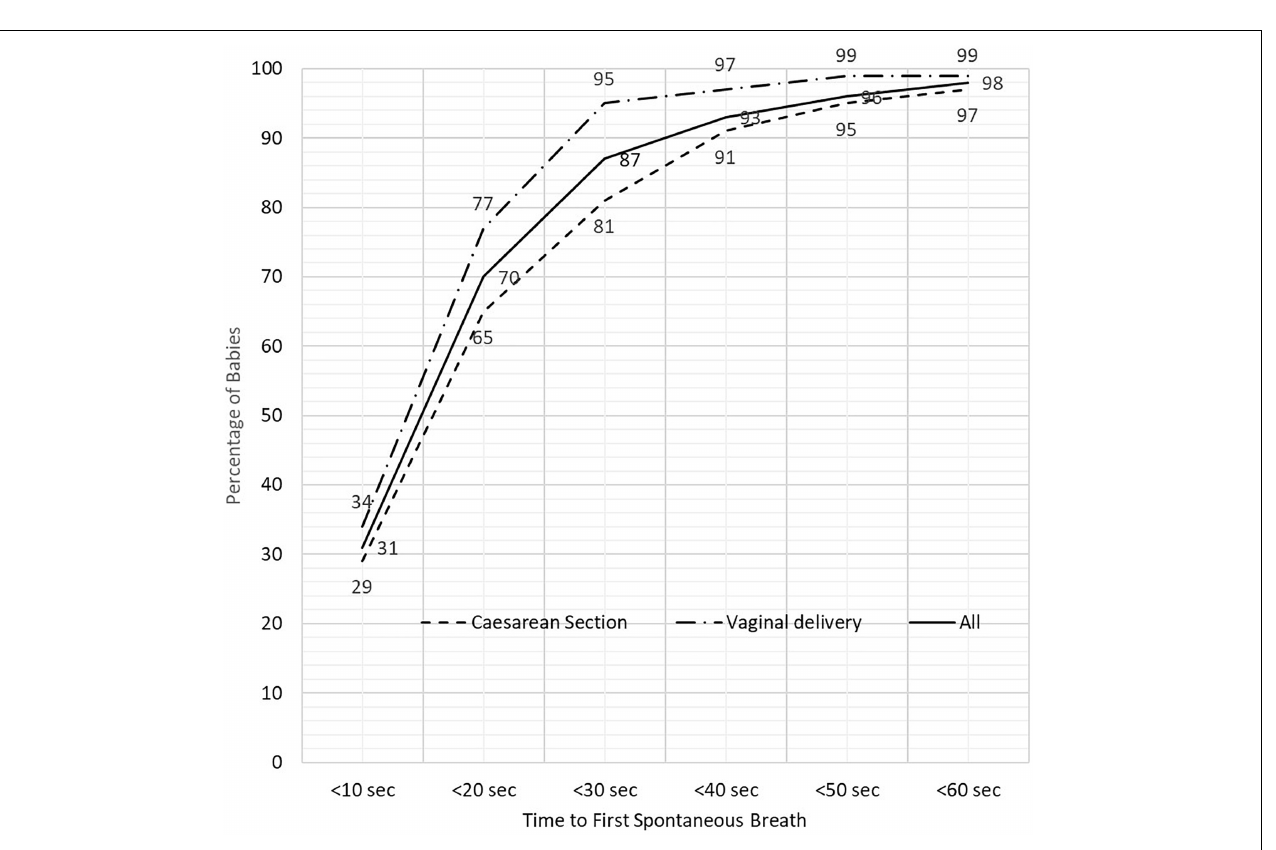
FIGURE 2 | The proportion of newborn babies breathing spontaneously according to time after birth and mode